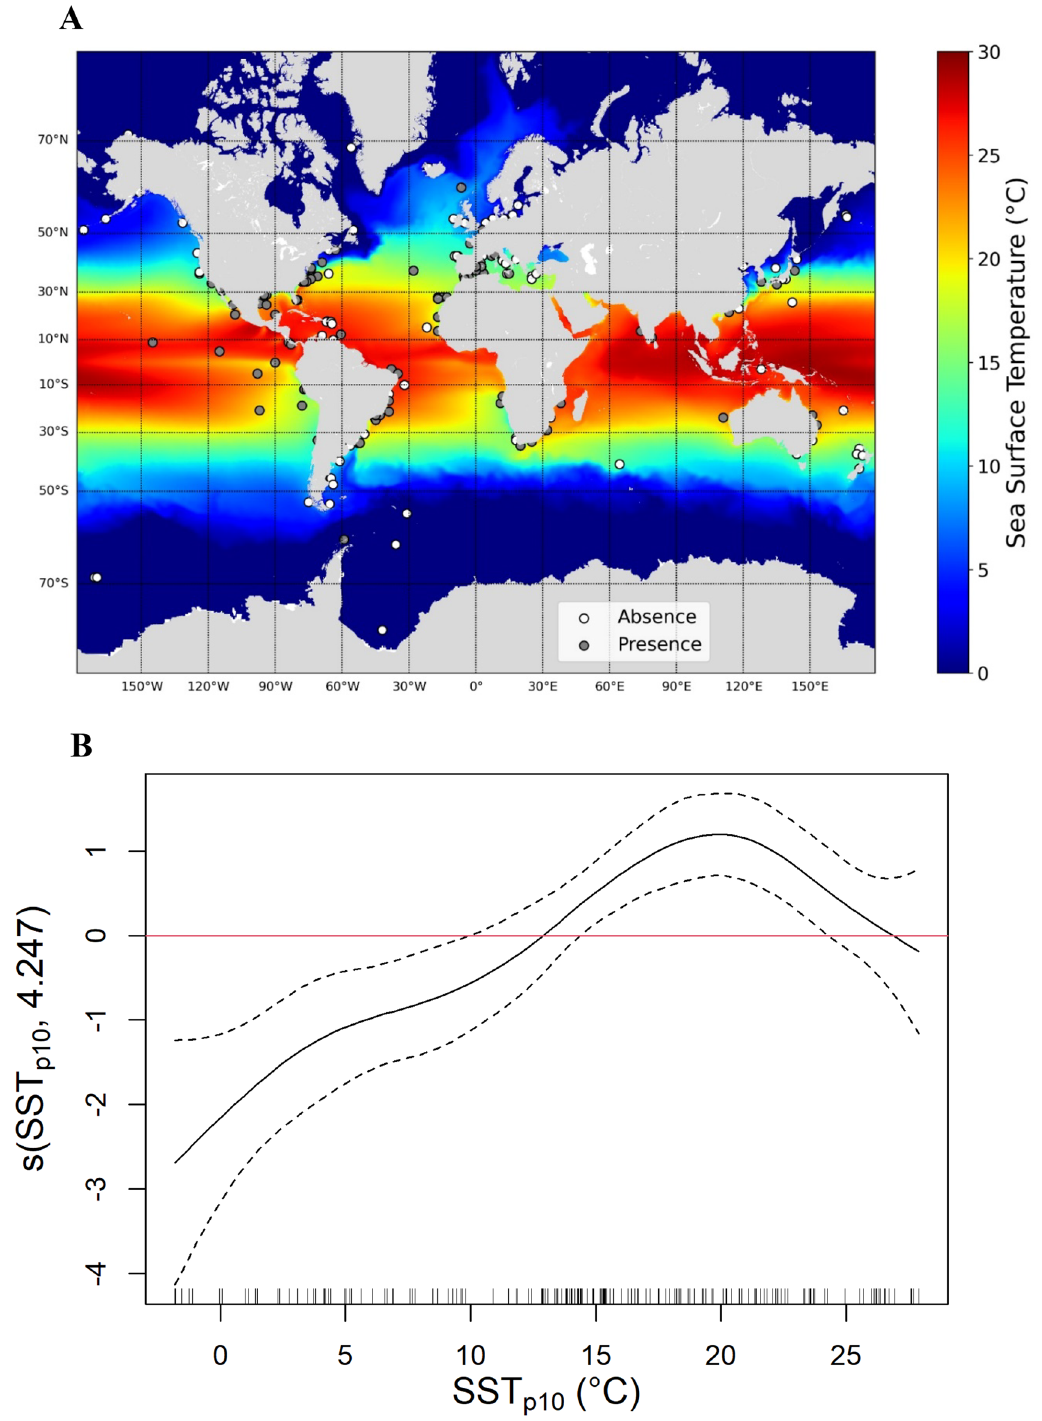
Figure 3. Latitudinal and temperature trends on the cetacean barnacle Xenobalanus globicipitis . ( A ) Data points obtained from a review of publications examining the external surface of cetaceans. Gray dots indicate presence of X. globicipitis , whereas white dots indicate absence. The color gradient indicates minimum sea surface temperature (SST q10 , see “Materials and Methods”). This figure was generated with Python (version 3.10.2). ( B ) Estimated smoother for the binomial GAM used to model the probability of X. globicipitis presence (data obtained from a literature review) as a smooth function of SST q10 . The solid line is the estimated smoother and the dotted lines are 95% point-wise confidence bands. Places where the confidence bands are wide and enclose the horizontal red line indicate values where the overall pattern is not significant 49 . The y-axis shows the contribution of the smoother, which is centered around zero, to the fitted